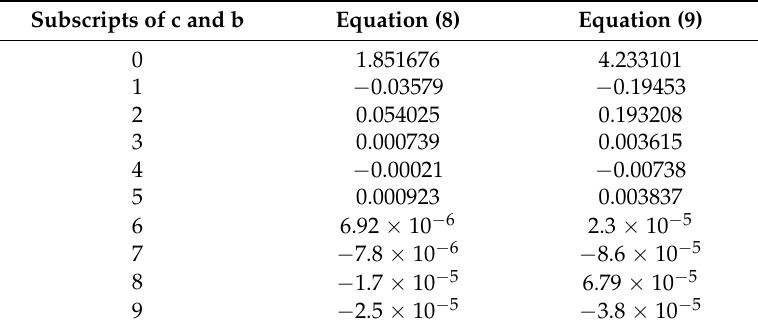
Table 2. Values of the coefficients in Equations (8) and